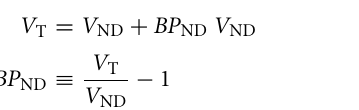
FIGURE 6 | Left panel shows relationship between the [ 11 C ] PIB estimated surrogate CBF measures and the standard [ 15 O ] water-measured CBF values for averages of healthy controls